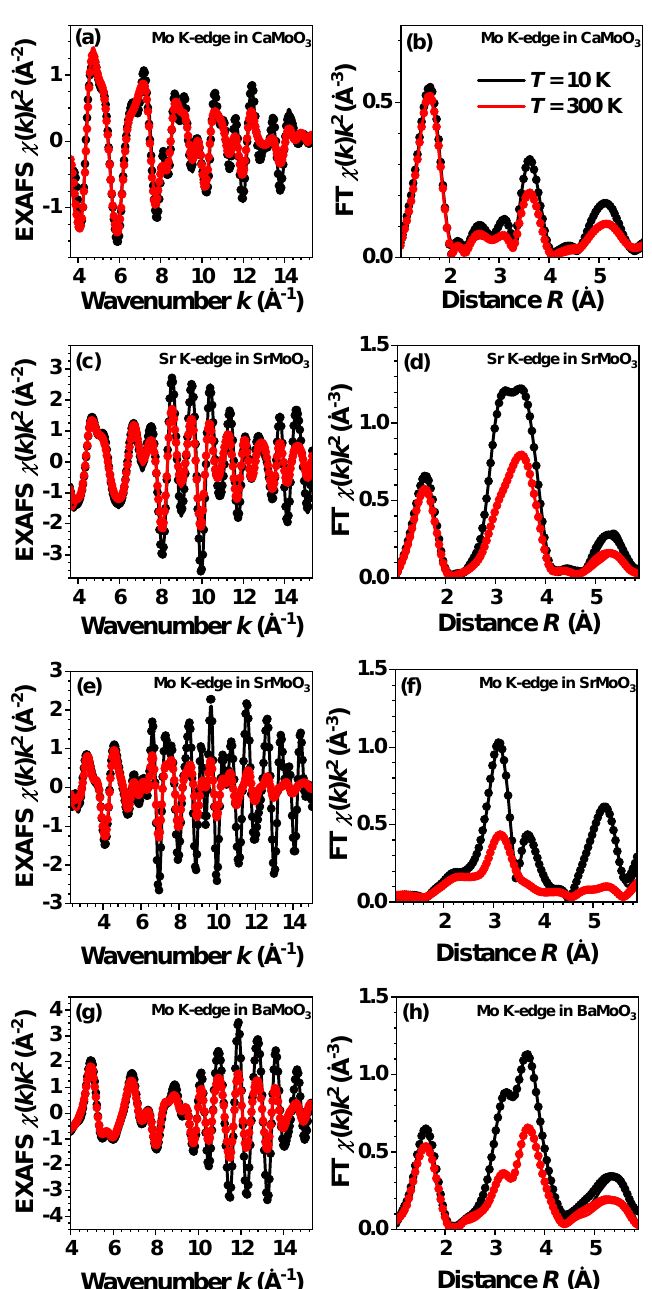
Figure 2. Experimental (dots) and simulated (solid lines) Mo K-edge extended X-ray absorption fine structure (EXAFS) spectra χ ( k ) k 2 (left panels) and their Fourier transforms (FTs) (right panels) at 10 K (black) and 300 K (red) in CaMoO 3 ( a , b ), SrMoO 3 ( e , f ), and BaMoO 3 ( g , h ). The data for Sr K-edge in SrMoO 3 are shown in ( c , d ). Only the moduli of the FTs are shown. See text for